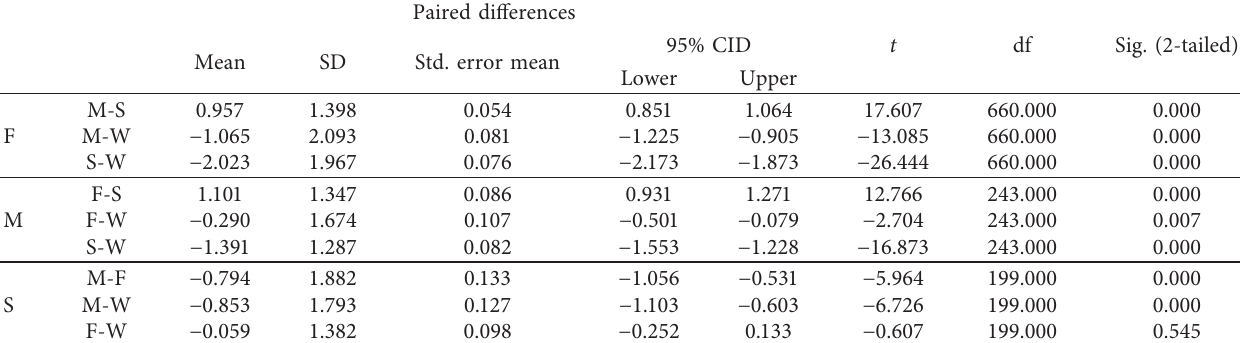
Table 5: Paired test analysis of the same role with other multiple